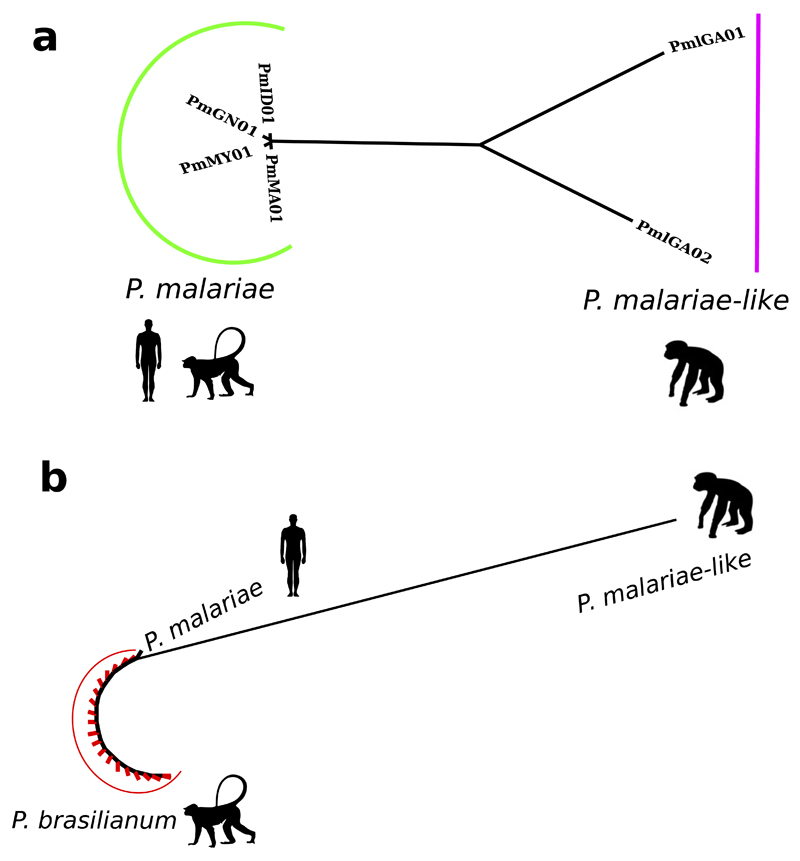
P. malariae-like has significantly longer branch lengths than P. malariae, and P. brasilianum is identical to P. malariae.a, A phylogenetic tree of all P. malariae and P. malariae-like samples generated using PhyML50 on the basis of all P. malariae genes. P. malariae samples are indicated by a green bar and P. malariae--like samples are indicated by a purple bar. Silhouettes represent host infectivity. b, A PhyML50 phylogenetic tree of all P. brasilianum 18S rRNA sequences9, indicated by a red bar and red tip branches, and the corresponding 18S rRNA sequences from the P. malariae and P. malariae-like assemblies, labelled as such. Silhouettes represent the host origin for each sample.